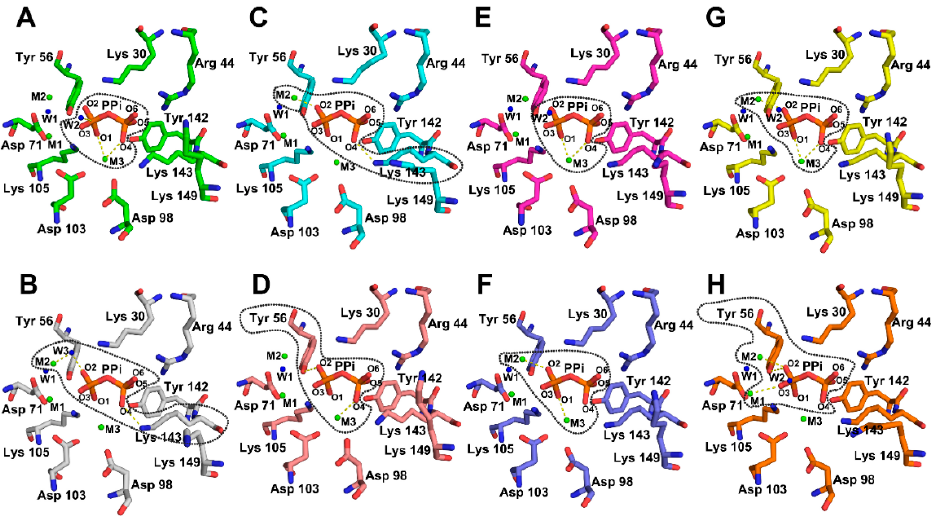
Figure 4. Variable PPi binding snapshots in eight AbPPase catalytic centers according to the distribution of electron densities. The dash lines delimit the regions where the electron densities of the atoms were fused with each other. Monomer ( A , B ), ( C , D ), ( E , F ), and ( G , H ) assemble into AbPPase hexamer 1, 2, 3, and 4. A water molecule (W2) from the solvent is close to the phosphate group and could be the real catalytic water ( A ). The left phosphate in PPi is named as Pi1 and the right one is named as